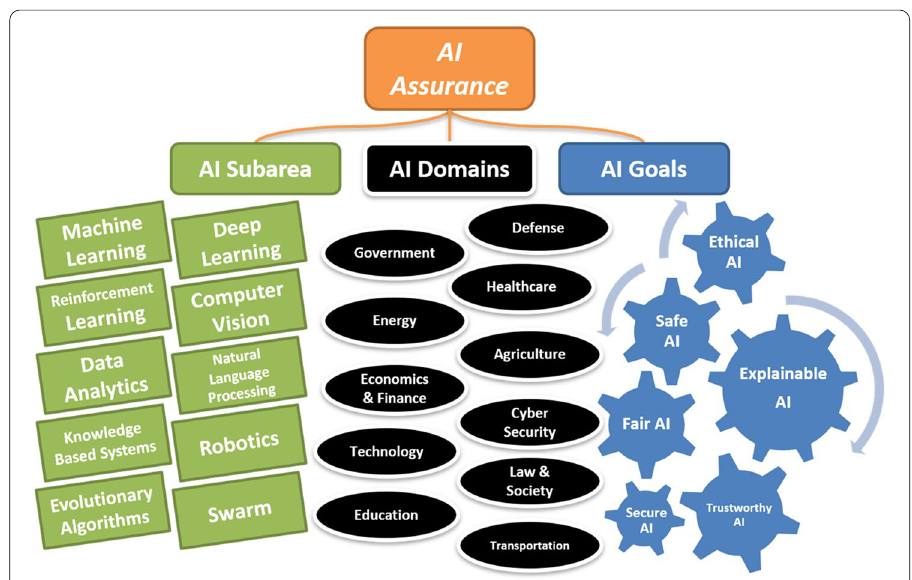
Fig. 3 Three‑dimensional AI assurance by subarea, domain, and